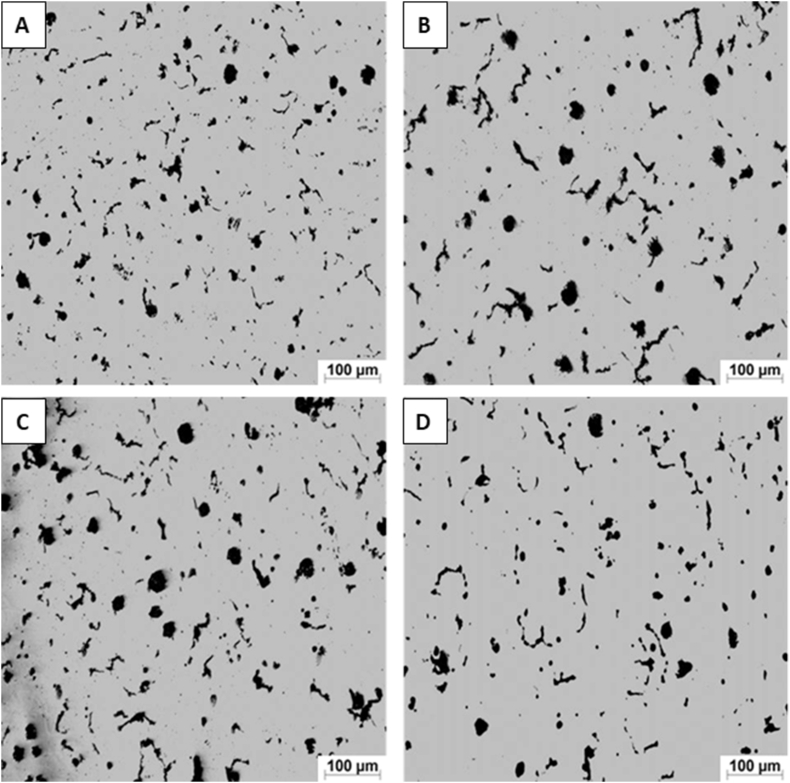
Nodularity % for sample number 1 with different thicknesses before etching: A) Wall thickness 5mm, nodularity % 32.65, B) Wall thickness 10mm, nodularity % 21.47,C) Wall thickness 15mm, nodularity % 16.34, and D) Wall thickness 20mm, nodularity % 14.21.